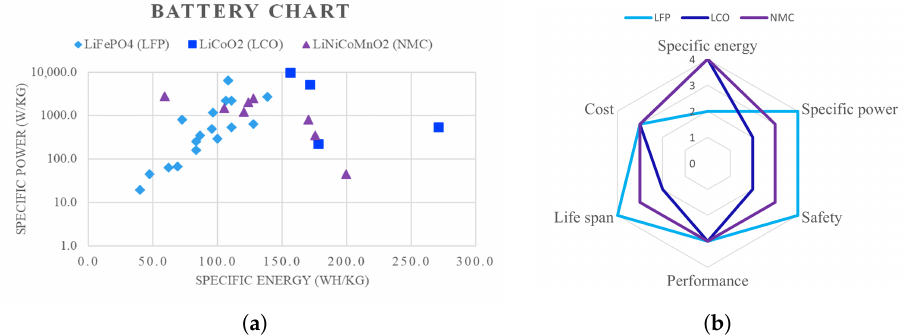
Figure 3. ( a ) Specific power vs. specific energy of Li-ion batteries distinguished by cell chemistry [55]. ( b ) Radar chart of LFP, LCO and NMC battery comparison